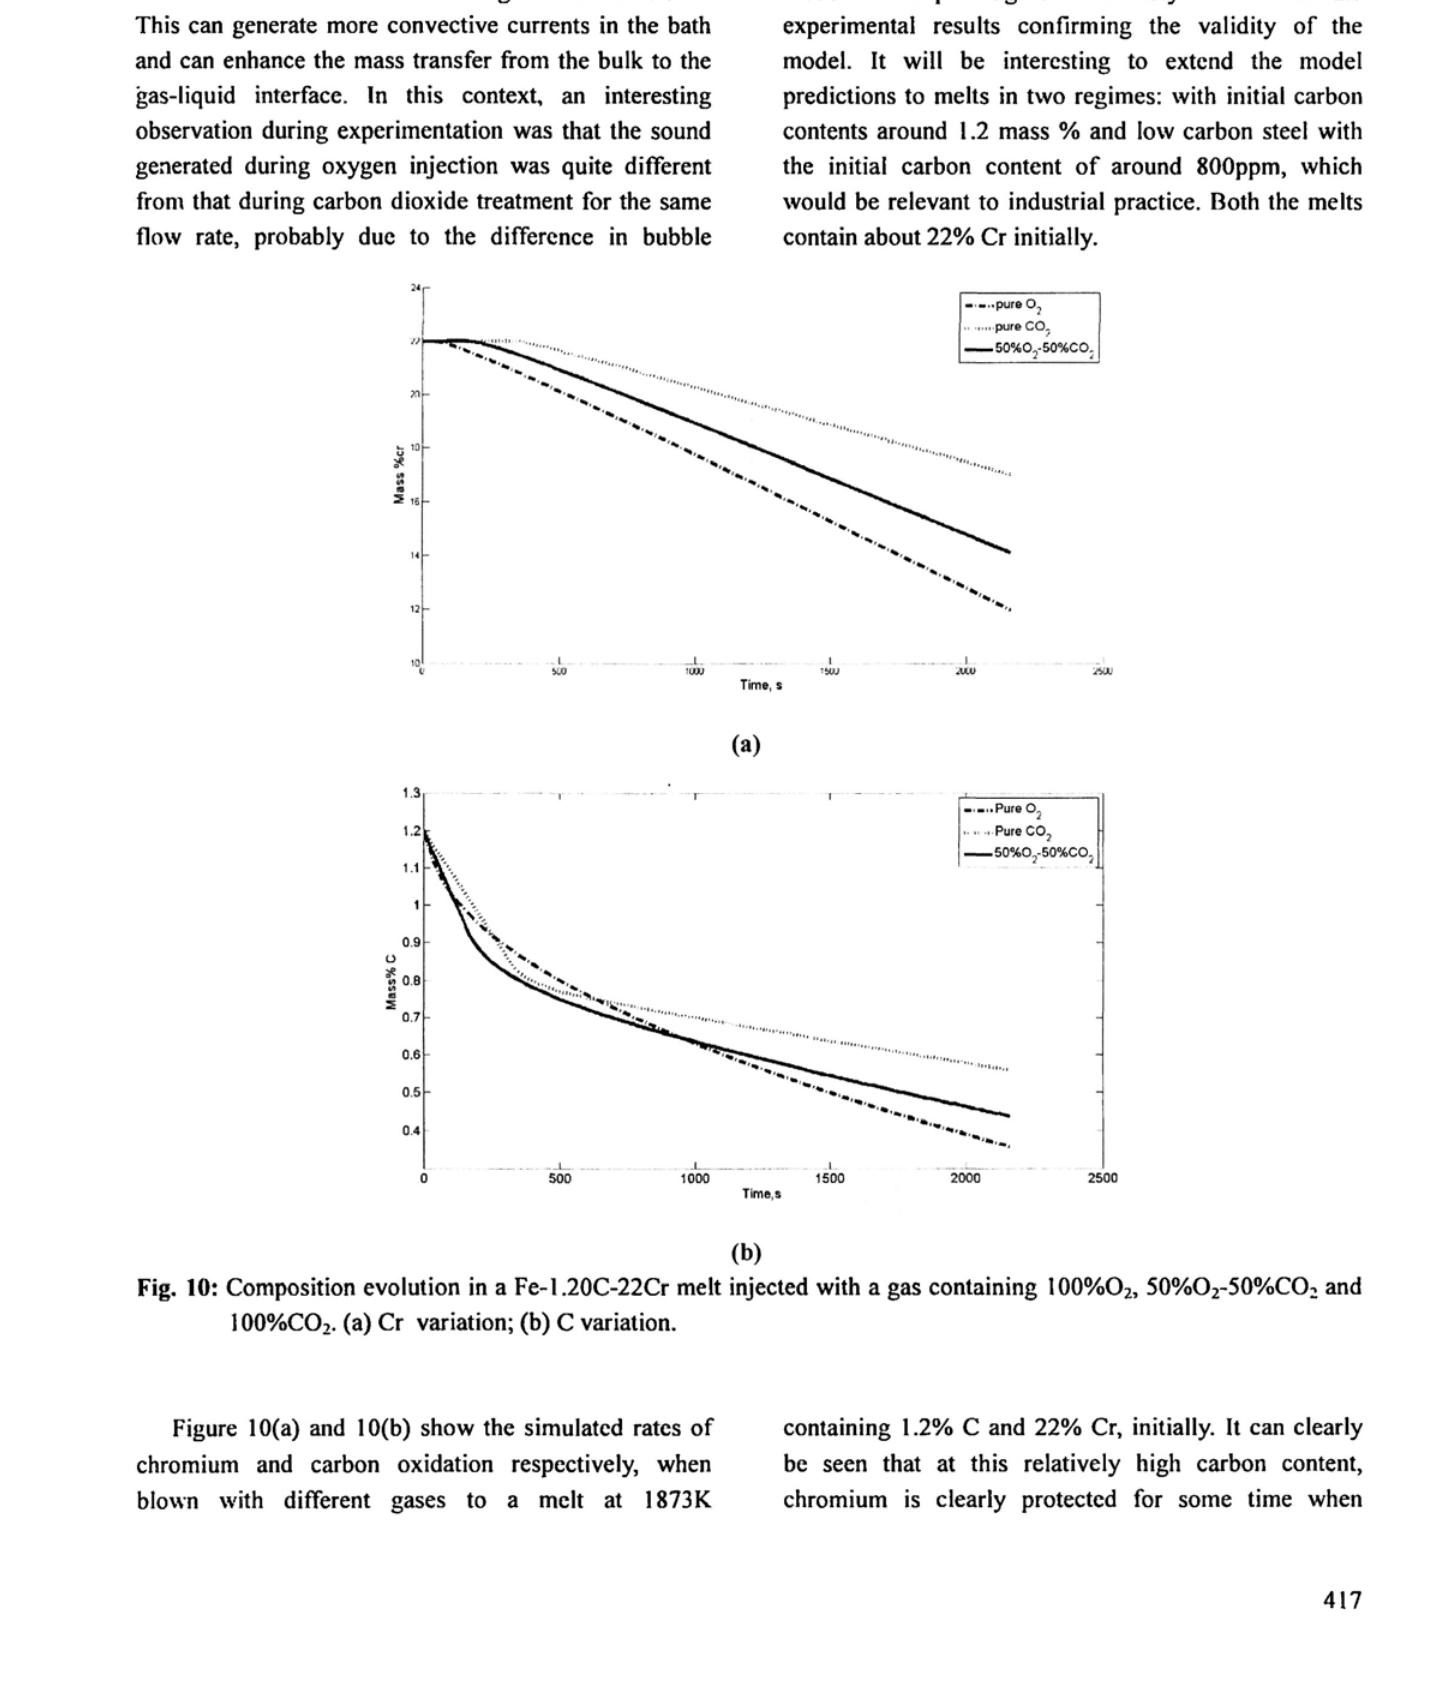
, 50%O -50%CO and 2 2 ;